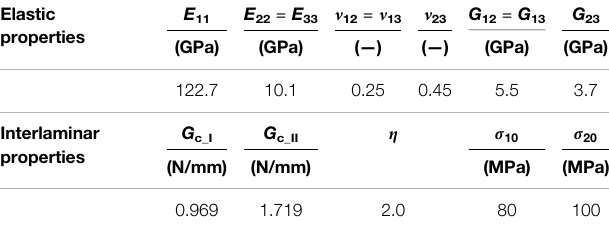
TABLE 3 | Four sets of values for the interlaminar strength used in the